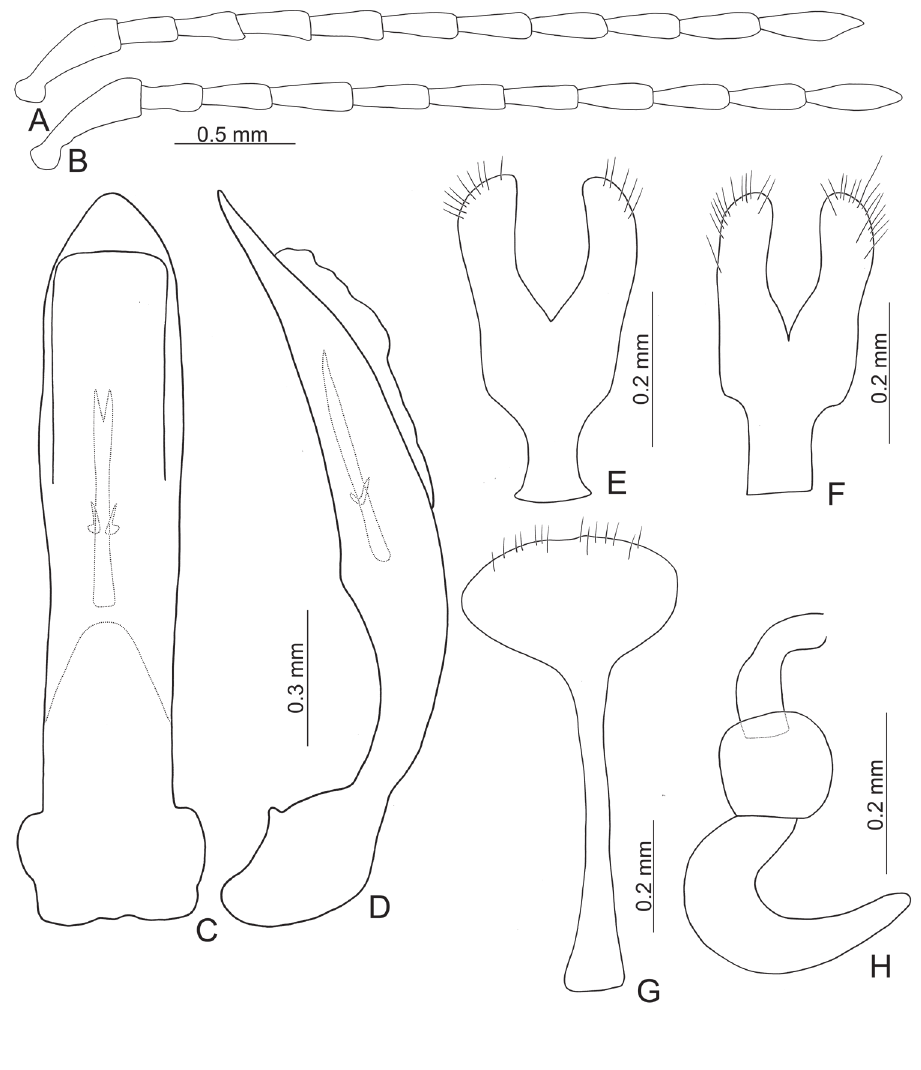
Figure 4. Diagnostic characters of Taiwanoshaira chujoi comb. nov. A antenna, male B antenna, female C penis, dorsal view D penis, lateral view E gonocoxae, from Tapan ( 達邦 ) F gonocoxae, from Pilu ( 碧 綠 ) G abdominal ventrite VIII H